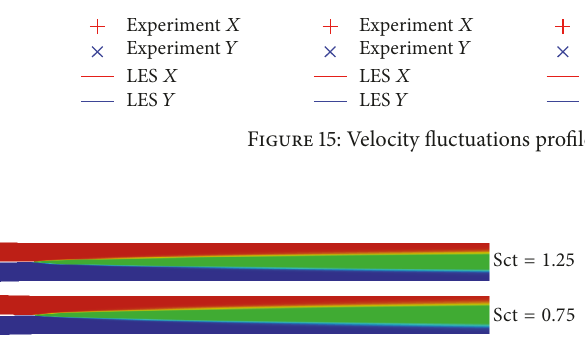
Figure 16: Influence of the turbulent Schmidt number on the shape of the mixing layer. The green colour represents a concentration variation from 0.1 to